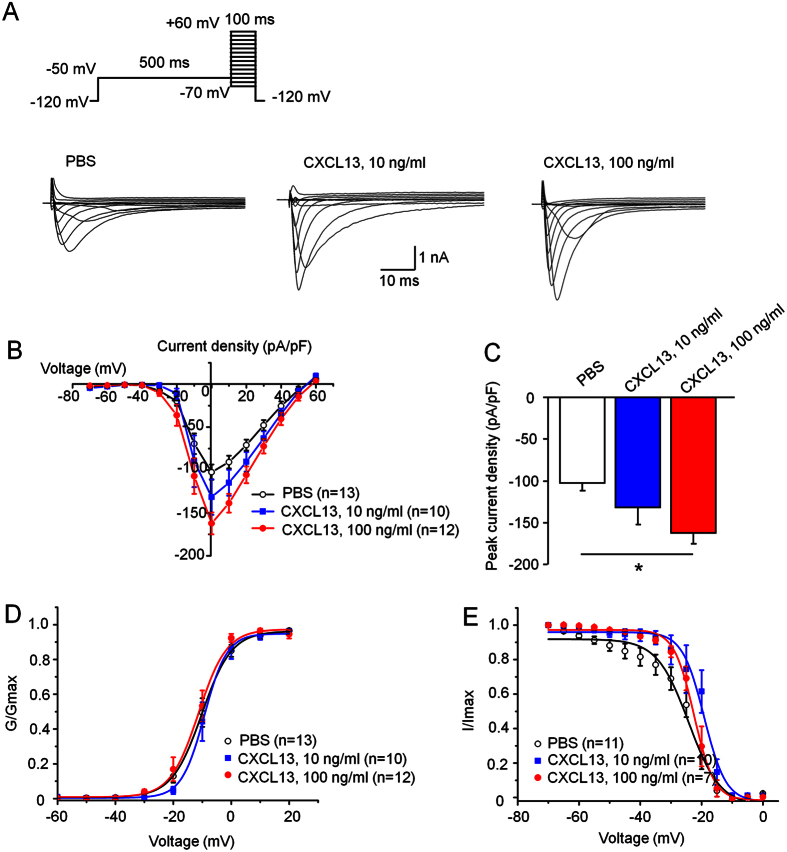
CXCL13 increases peak current density of TTX-R Nav1.8 in DRG neurons of naïve mice.(A) I–V curve family of currents was measured using the protocol with a 500 ms prepulse to -50 mV before each activating pulse. (B) Examples of voltage-clamp traces illustrating Nav1.8 current recorded following 30 min treatment with vehicle (PBS) or CXCL13 (10 ng/ml or 100 ng/ml). (C) The mean currents versus voltages (I–V) curves of Nav1.8 in DRG neurons. The peak current density of Nav1.8 was significantly enhanced in neurons pretreated with 100 ng/ml CXCL13. One-way ANOVA (F2,32 = 4.9346, P < 0.05). *P < 0.05, post hoc Bonferroni test. (D) Activation curves for Nav1.8 currents reveal no significant difference following CXCL13 treatment. (E) The steady-state inactivation curves for Nav1.8 currents also show no significant differences. P > 0.05, post hoc Bonferroni test.